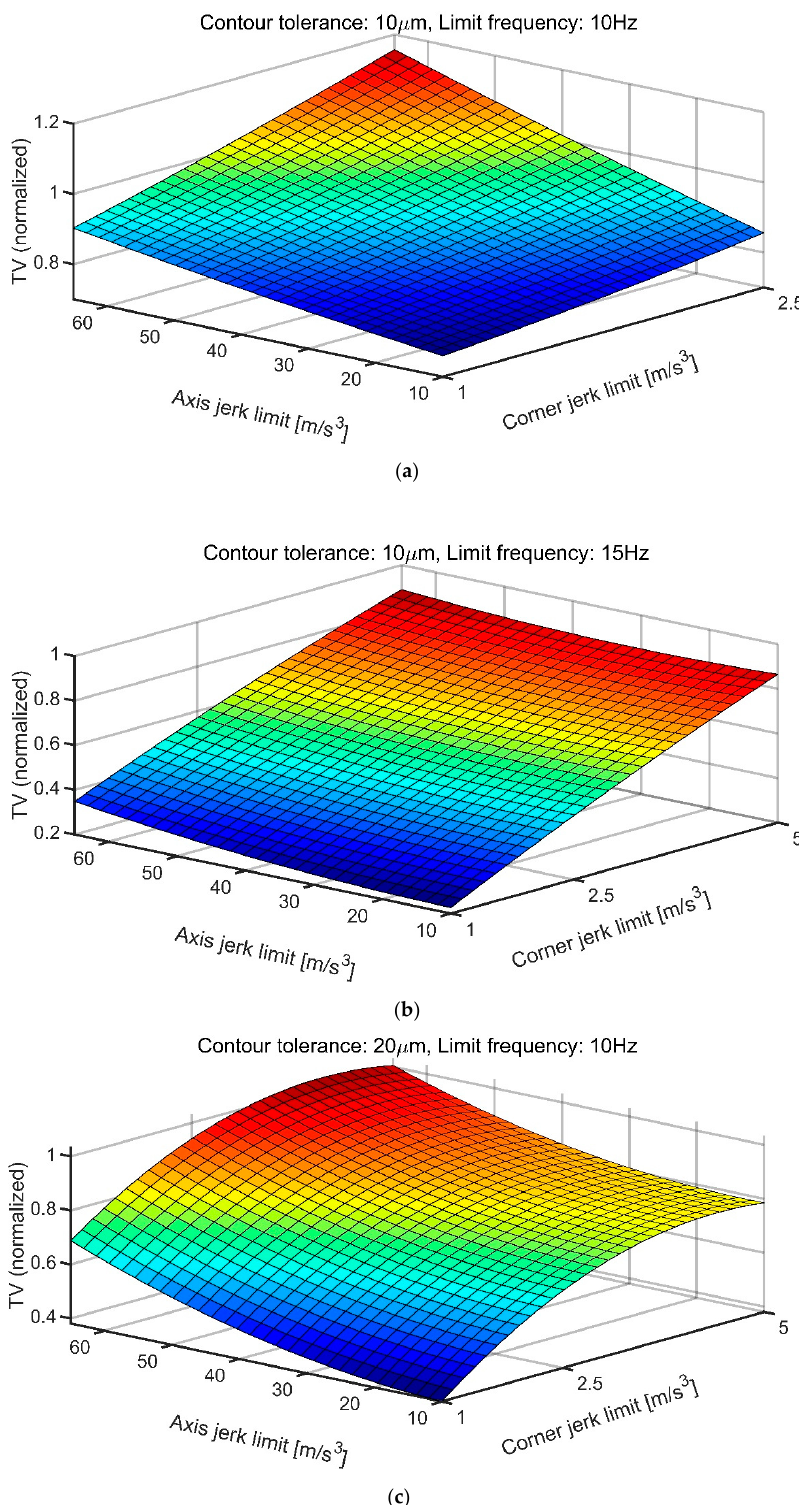
Figure 10. Regression models describing the joint dependence of a (normalized) TV coefficient on the corner jerk limit and the axis jerk limit for the low-tolerance low-limit frequency test combinations: ( a ) contour tolerance 10 µ m; limit frequency 10 Hz (corner jerk threshold 2.5 m/s 3 ); ( b ) contour tolerance 10 µ m; limit frequency 15 Hz (corner jerk threshold 5 m/s 3 ); ( c ) contour tolerance 20 µ m; limit frequency 10 Hz (corner jerk threshold 5 m/s 3 ). The colors of the response surfaces correspond to the respective values of the normalized TV An illustrative demonstration of the effect of corner jerk limit settings on the distri- bution of toolpath deviations in corner neighborhoods and its effect on the TV parameter is presented in Figure 11.